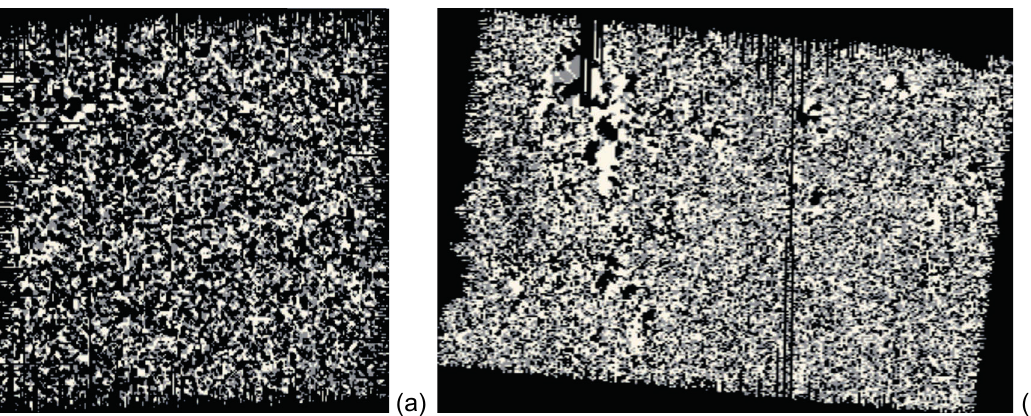
Fig. 4 Example of differential maps in the middle section of the slope: (a) plot A, (b) plot B. White – accumulation, black – erosion, grey – absence of changes within the scanner accuracy (± 2.5